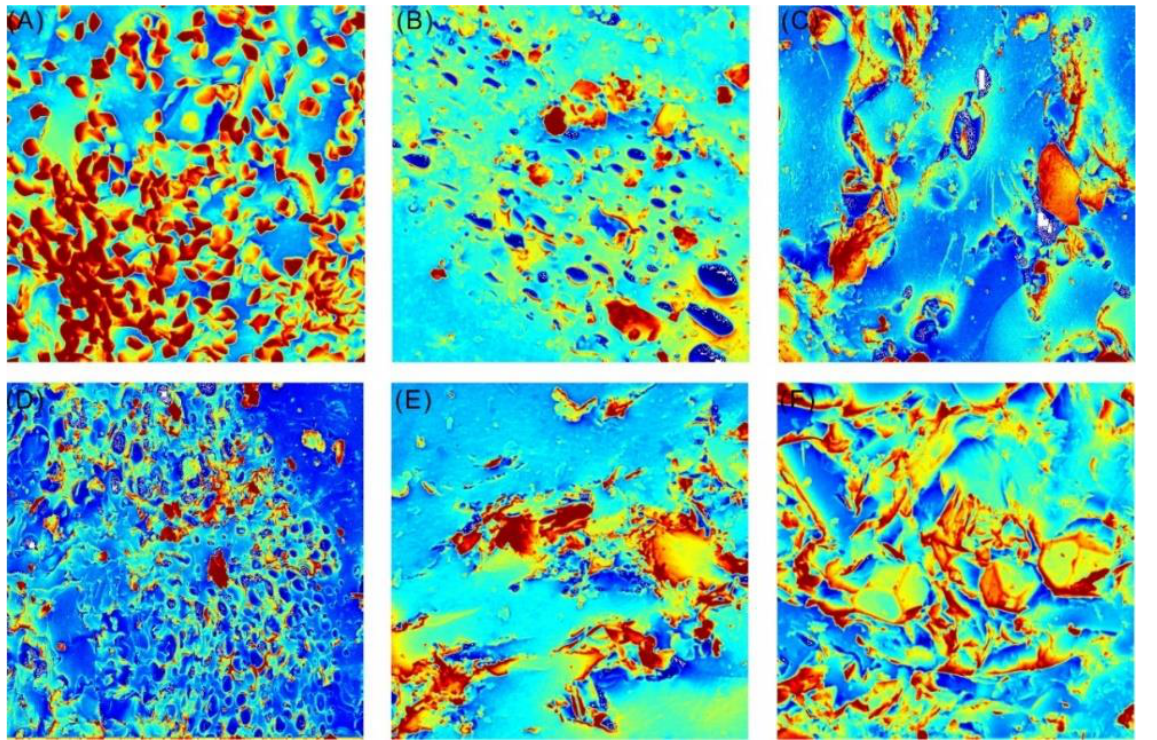
Figure 4. ( A – F ) Adaptive threshold images corresponding to Figure 2A – F.